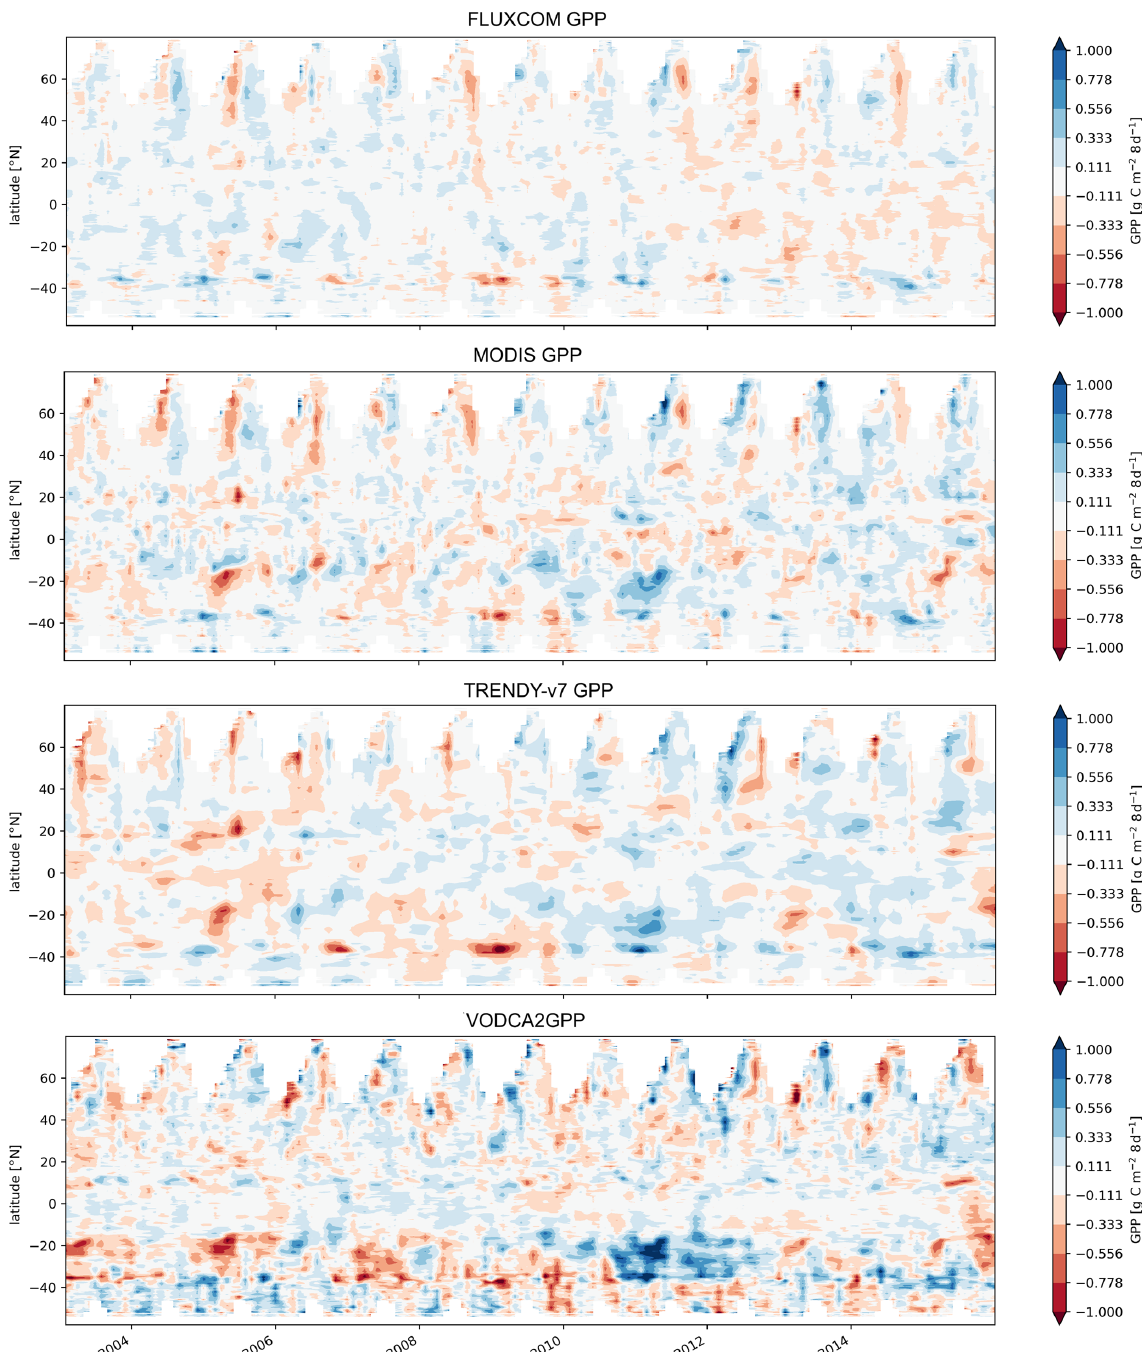
Figure A4. Hovmöller diagrams of monthly GPP anomalies for each dataset.